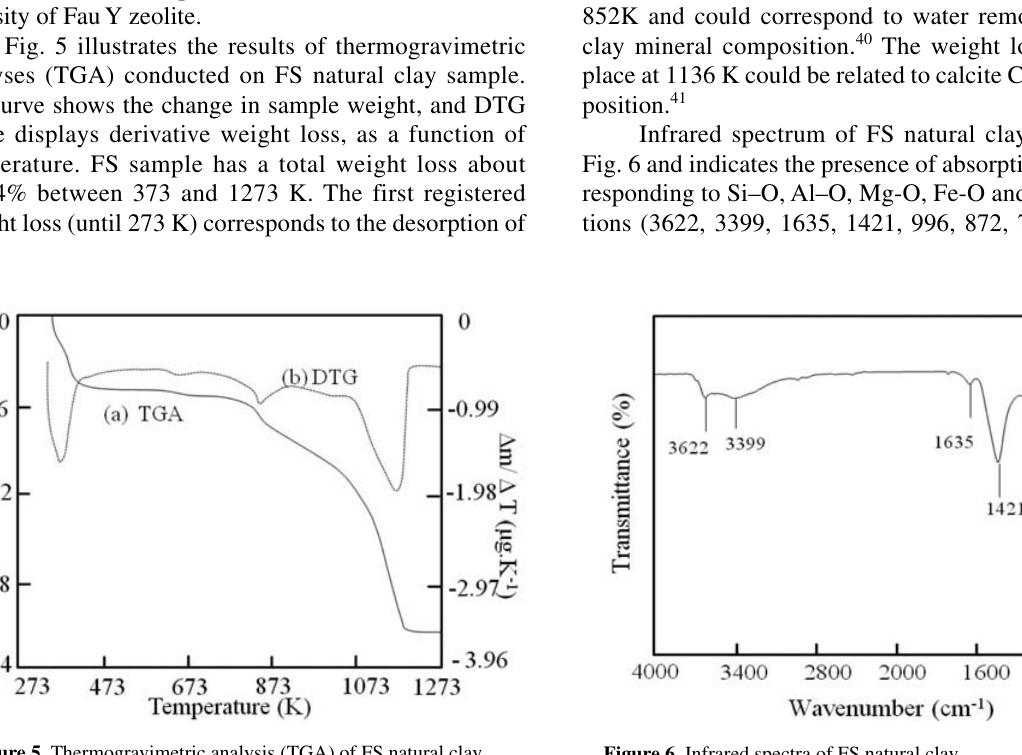
Figure 5. Thermogravimetric analysis (TGA) of FS natural clay Figure 6. Infrared spectra of FS natural clay